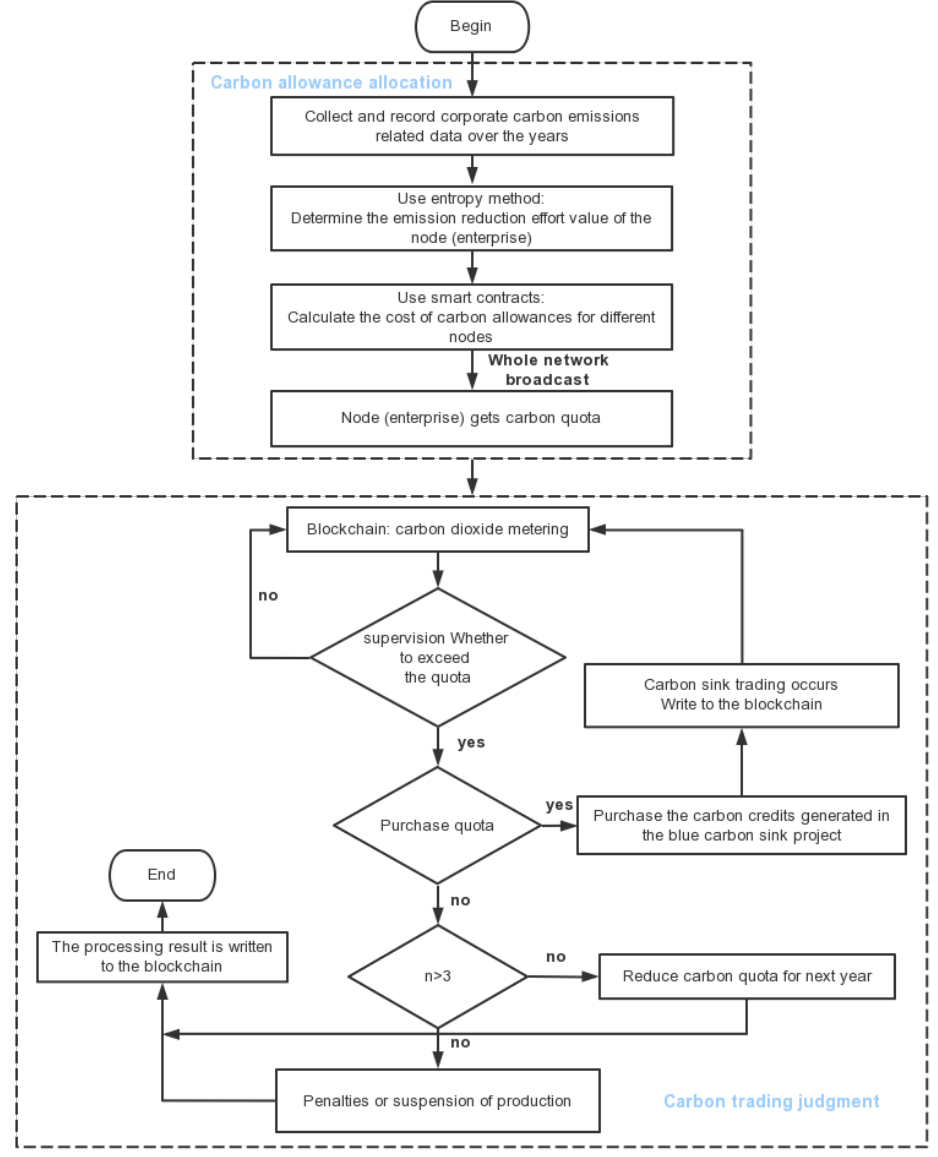
Figure 5. Flow chart of carbon sink transaction source traceability under blockchain. (Source: Collated from [60,61]).